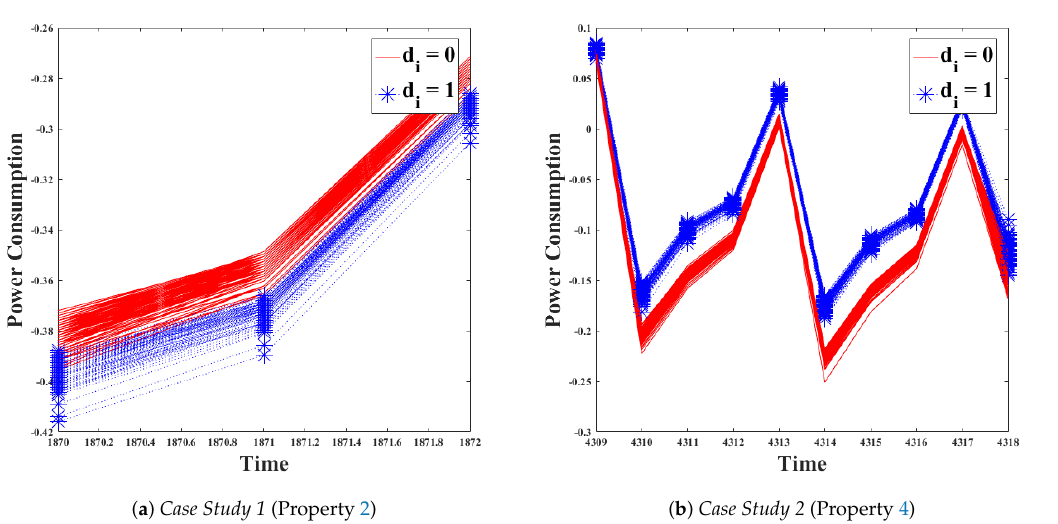
Figure A3. Software implementation (OpenSSL): one of the subtraces ( top ), and the SOST value between two subgroups ( bottom ).